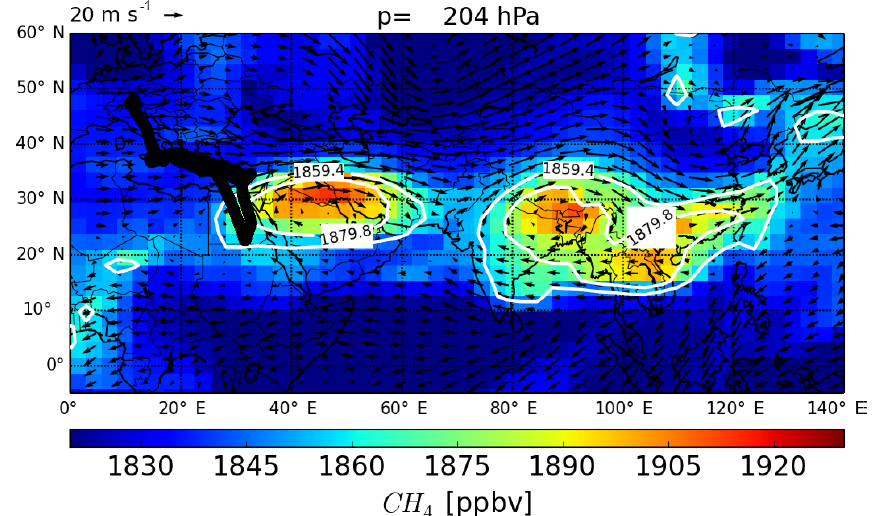
Figure 19. Double anticyclone mode illustrated with wind field and CH 4 EMAC daily means at 204hPa (25 August 2015) and the associated flight tracks. White contours represent the CH 4 threshold and background values according to Sect.